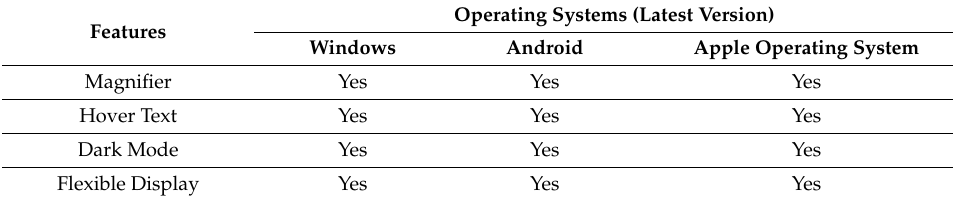
Table 14. OS and their features from